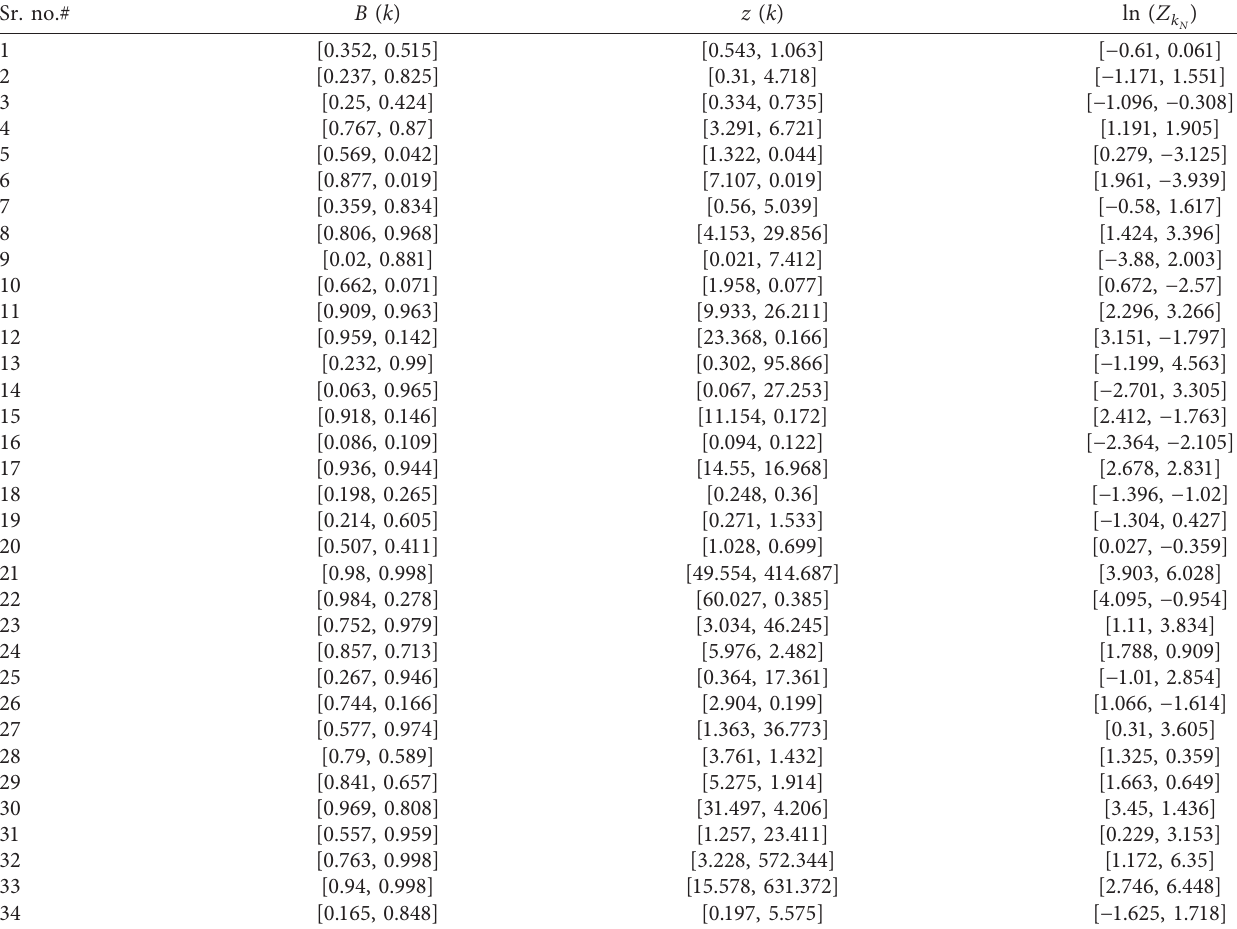
Table 7: The simulated data for the existing